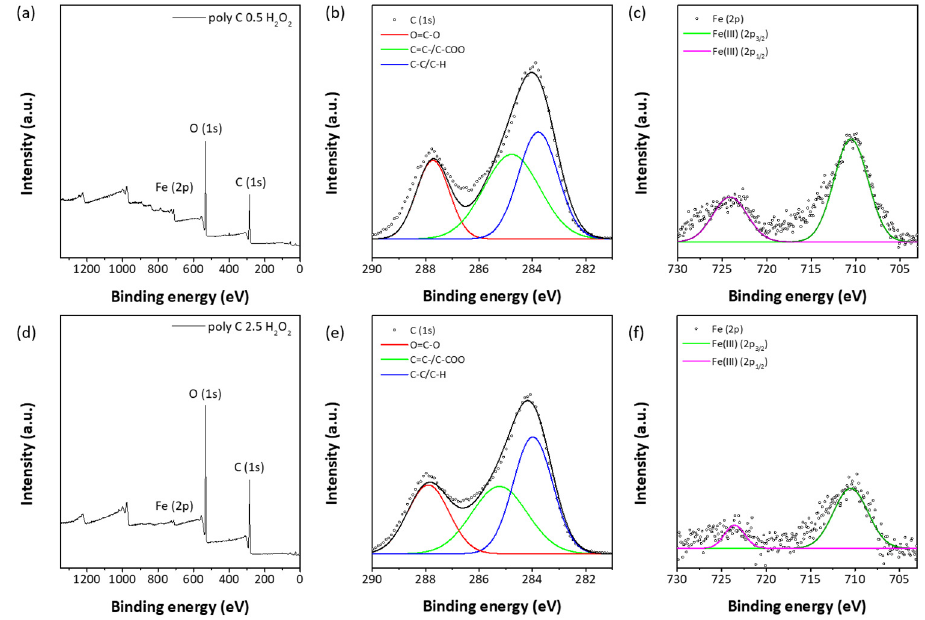
Figure 7. XPS spectra of FPP (poly C0.5) and FPF (poly C2.5) samples treated with H 2 O 2 aqueous